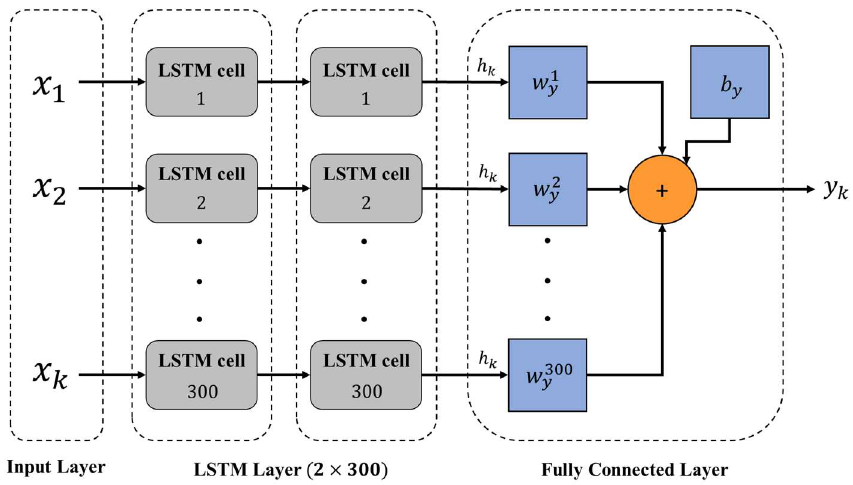
Figure 17. LSTM architecture.